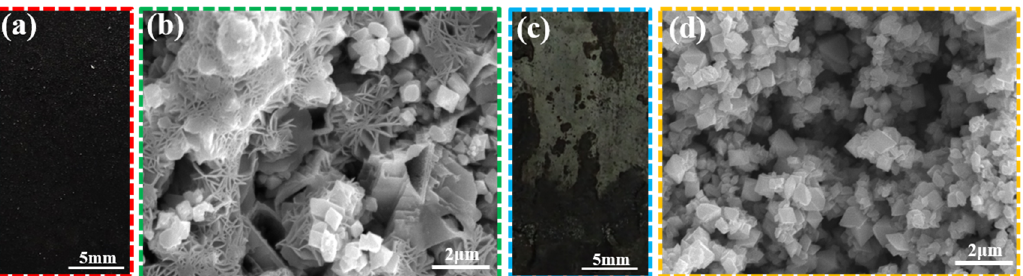
Figure 8. Macro ‐ morphology and micro ‐ morphology of 35CrMo steel used for wellhead. (( a , b ): liquid phase; ( c , d ): gas phase). phase; ( c , d ): gas phase).